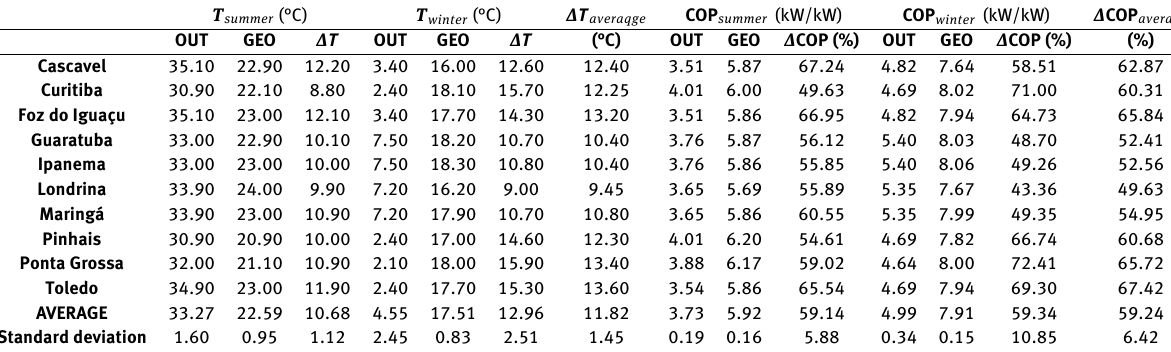
Table 3: Temperature data, COP and efficiency gain in all Paraná measuring stations. T summer (°C) T winter (°C)